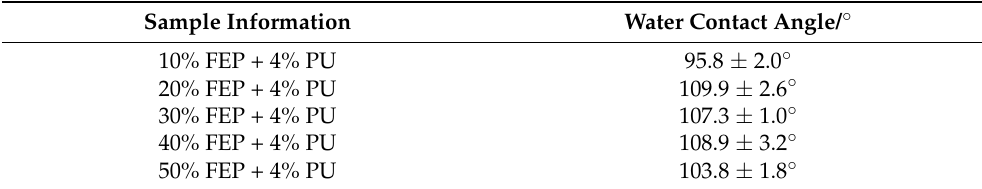
Table 1 . Water contact angle (WCA) of M-CF/EP composites with 4% PU and different contents of FEP.